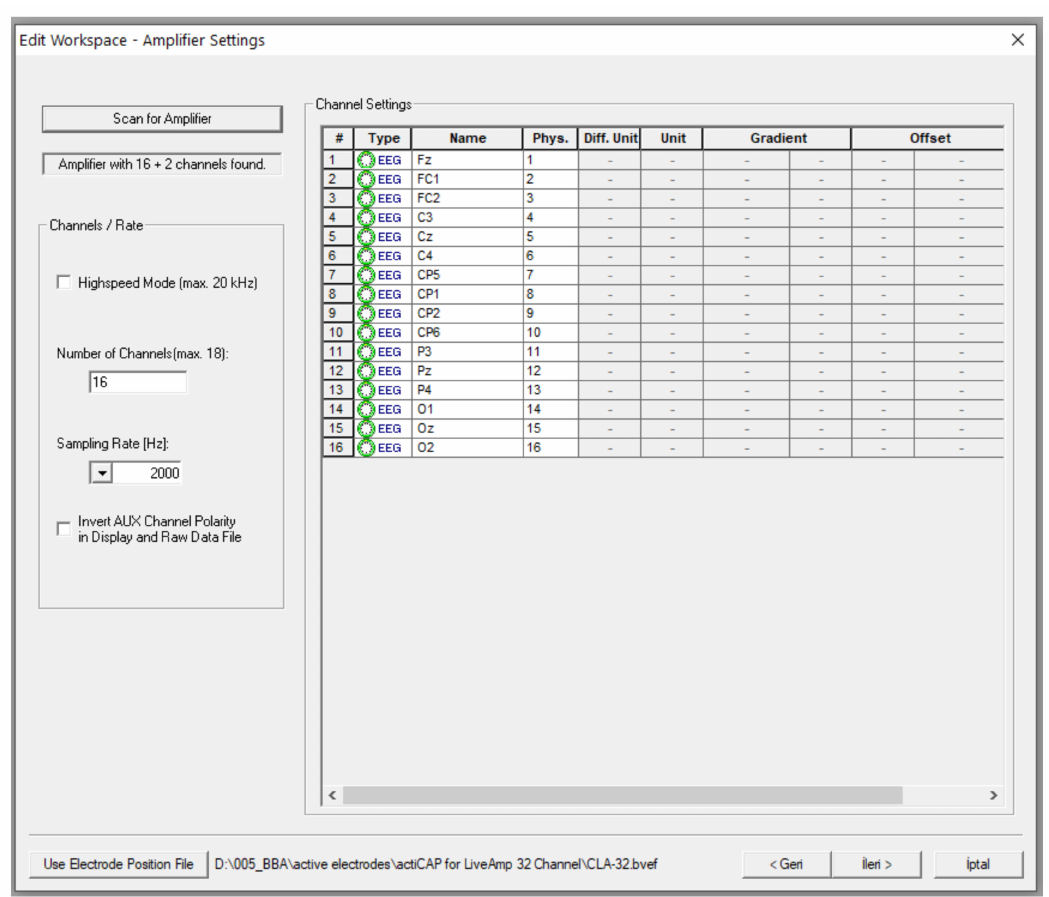
Figure 5. Recorder software settings in the EEG signal